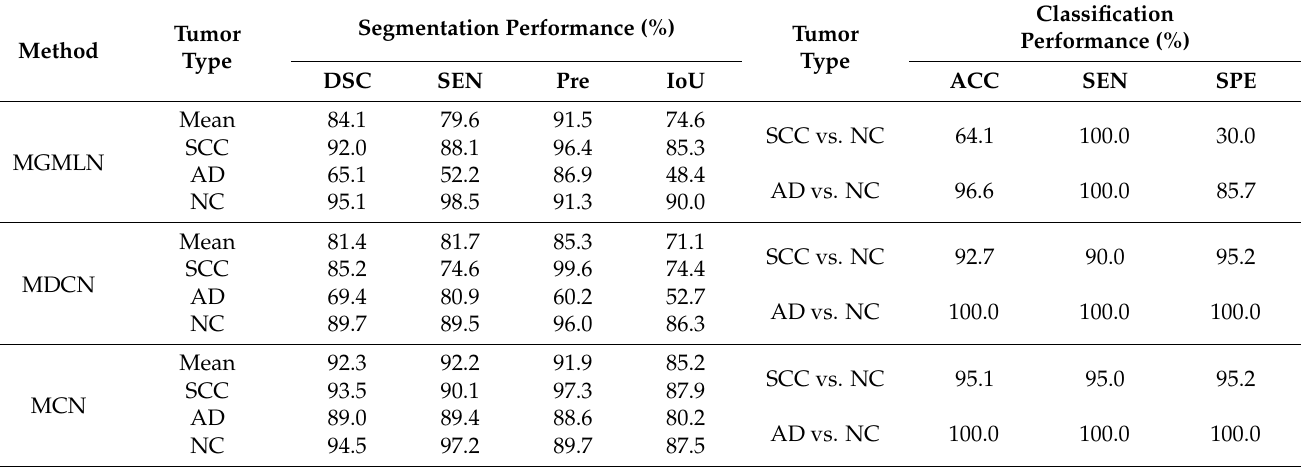
Table 3. Comparison of our method with other multi-task methods for segmentation and